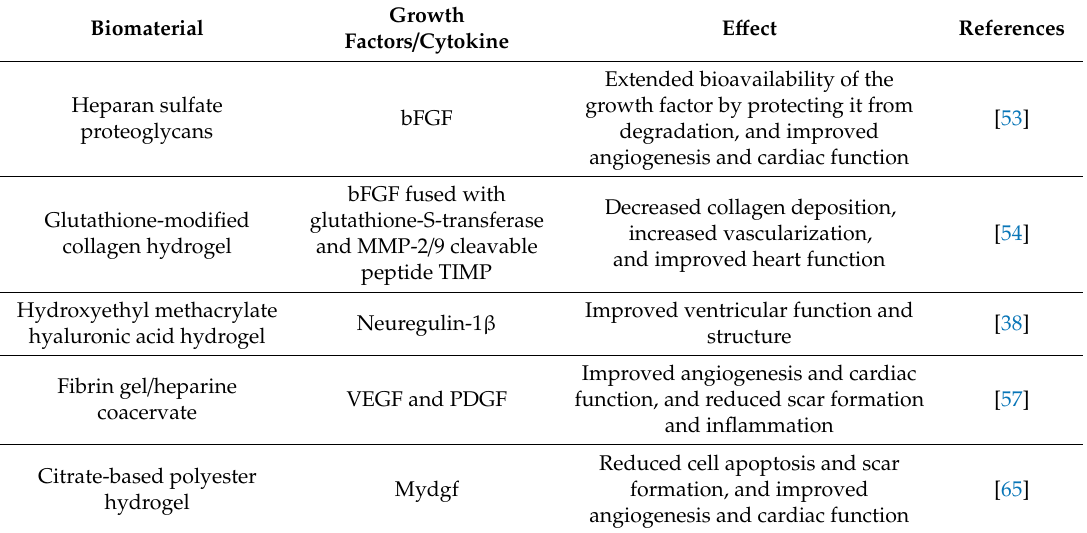
Table 1. Biomaterials loaded with growth factors and cytokines for cardiac tissue regeneration.